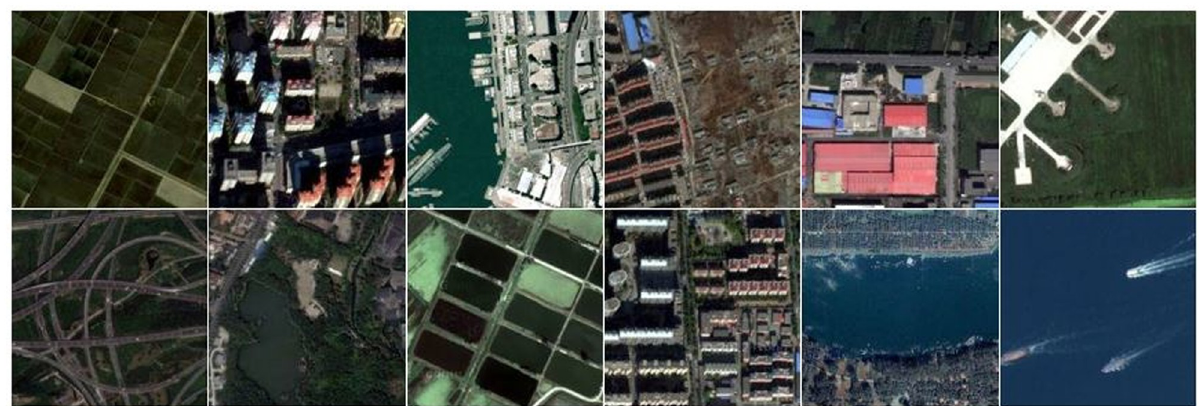
Fig 5. A photo gallery of images from SIRI-WHU dataset.